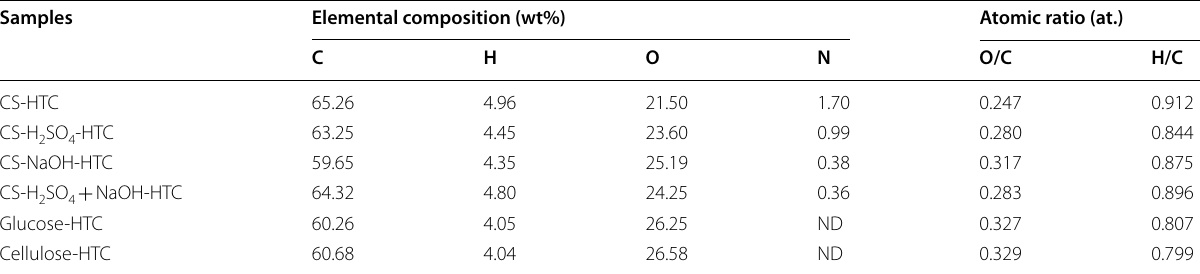
ND not detected